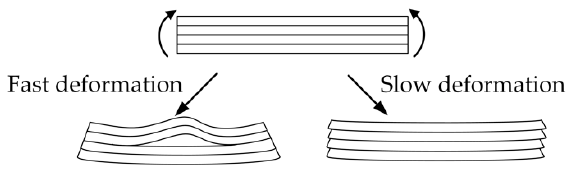
Figure 18. Formation of wrinkles as a result of deformation rate, adapted from [87].